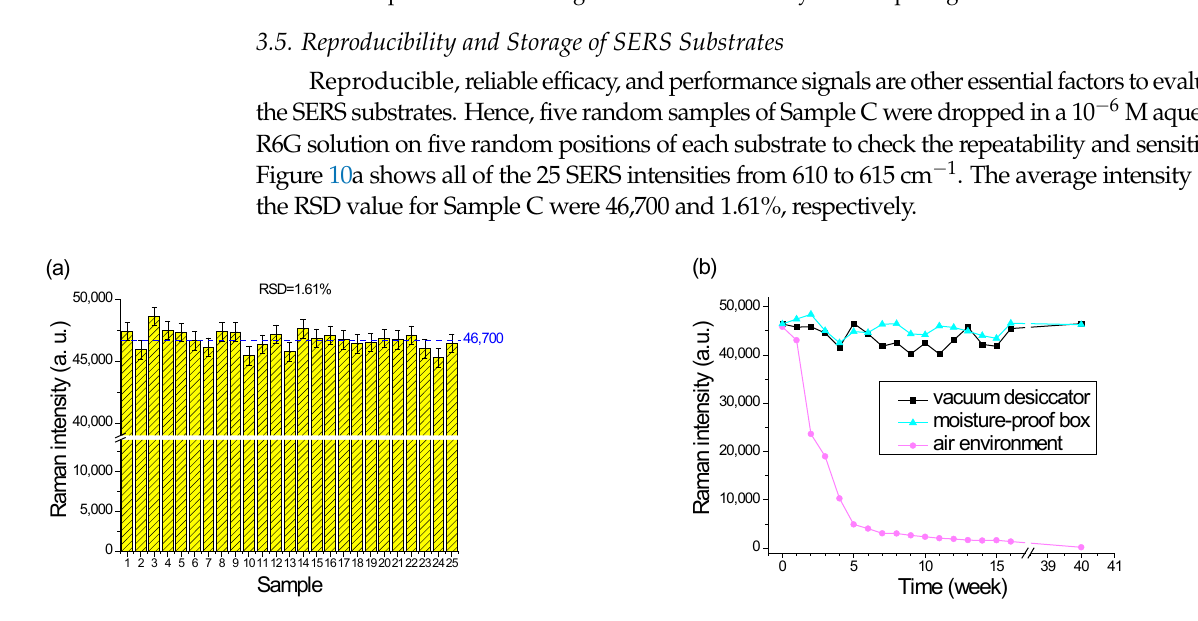
Figure 10. ( a ) The reproducibility of the SERS substrate evaluated by a 10 − 6 M concentration of R6G. ( b ) Lifetime comparisons of the SERS Sample C storage up to forty weeks in a vacuum desiccator, a moisture-proof cabinet, and an air environment.